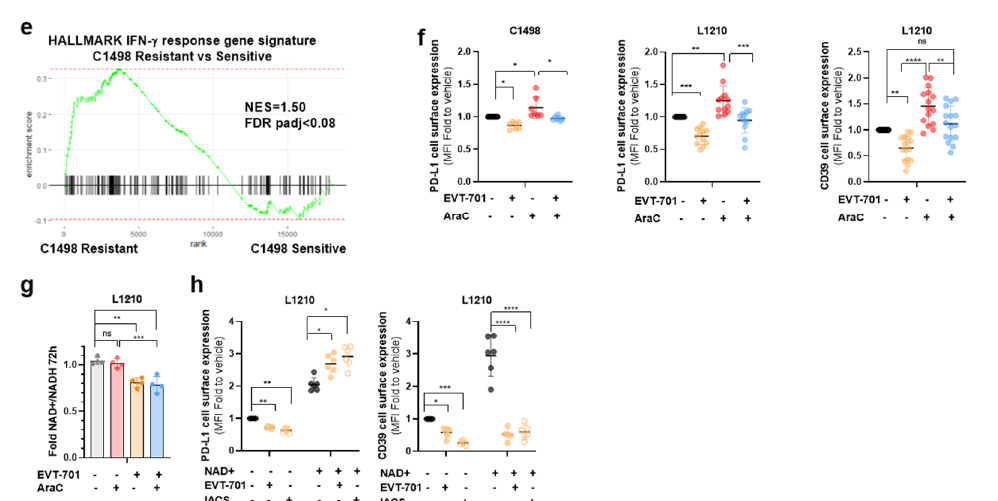
Figure 4. EVT-701 decreases the immune checkpoint expression to boost the immune response and increase the therapeutic benefit. ( a ) Volcano plot showing GSEA results in the GSE97631 data set containing the transcriptomic profiles of residual AML in PDXs AraC or vehicle-treated. Immune modulation-related gene signatures are in purple. In the middle, a plot showing AraC vs. PBS-treated PDXs differentially expressed gene sets with their normalized enrichment scores (NES). On the right, the enrichment plot of the hallmark Interferon- γ gene signature compatible with PD-L1 increases after AraC in vivo. ( b ) Enrichment plots of the hallmark Interferon- γ gene signature ( left ), KEGG purine metabolism-containing CD39 ( middle ) and Reactome PD-1 signaling ( right ) in the short group survival of the TCGA cohort. ( c ) Plot showing CD39- and PD-L1-related signatures in the short group of the TCGA cohort with their normalized enrichment scores (NES). ( d ) FACS assessment of the modulation of inducible PD-L1 and CD39 membrane expression on THP1 and MOLM13 cells by EVT-701, AraC or a combination of both ( n > 10). ( e ) Enrichment plot of the hallmark Interferon-γ gene signature in C1498-resistant vs. -sensitive cell transcriptomes. ( f ) FACs assessment of the modulation of inducible and CD39 membrane expression on C1498 ( n = 7) and L1210 ( n > 10) by EVT-701, AraC or a combination of both at 72 h. ( g ) Effect of EVT-701, AraC or a combination of both on the NAD+/NADH ratio in L1210 at 72 h ( n = 4). ( h ) Effect of exogenous NAD+ on the modulation of PD-L1 and CD39 membrane levels by EVT-701 or with IACS ( n = 6). * is p < 0.05, ** is p < 0.01, *** is p < 0.005, **** is p < 0.001, ns is statistically non-significant.